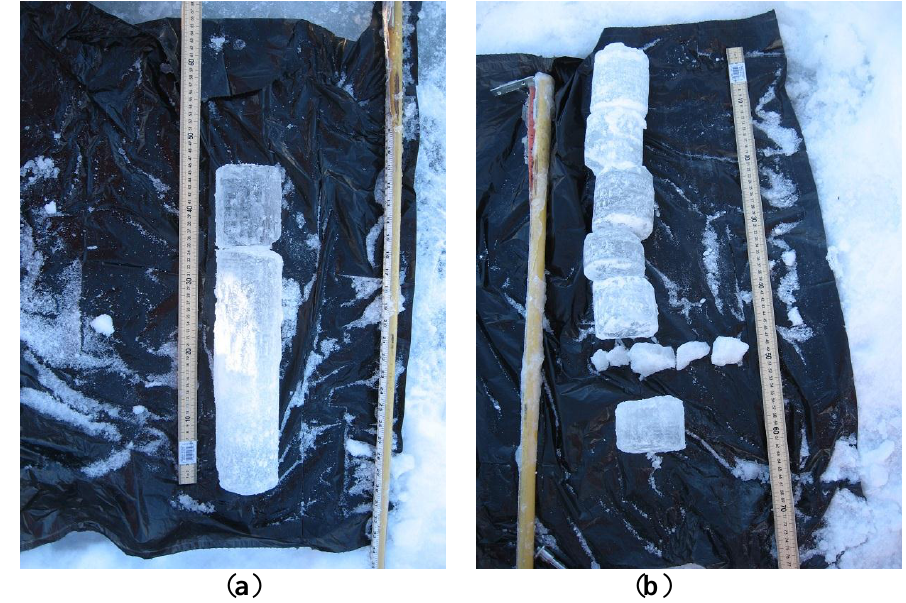
Figure 18. Thermal ice samples between Big Eddy and Nagle Channel ( a ) and between Nagle Channel and Steamboat Channel ( b ), collected during the field survey on 30 January 2015.